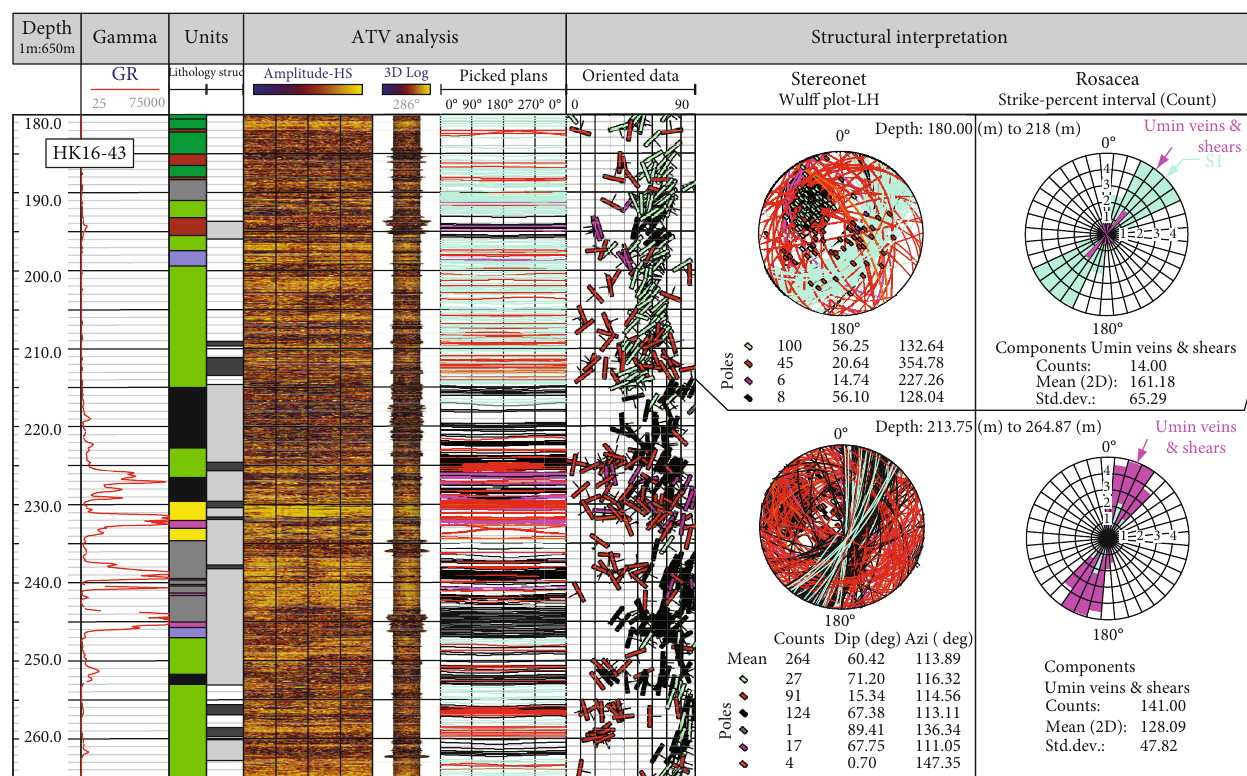
Figure 17: ATV data structural analysis from drill HK16-43 ATC and structural interpretation. Note the rotation of the nonmineralized (blue, upper interval) to the mineralized (black, lower interval) shears from NE to NNE. Umin: uranium